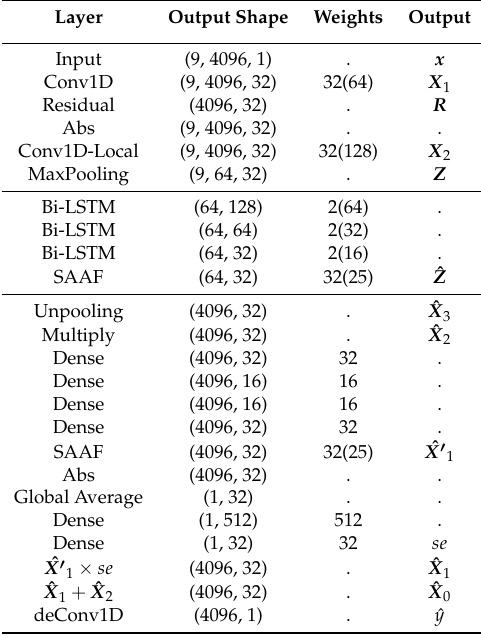
Table 4. Detailed architecture of a model with input frame size of 4096 samples and ± 4 context